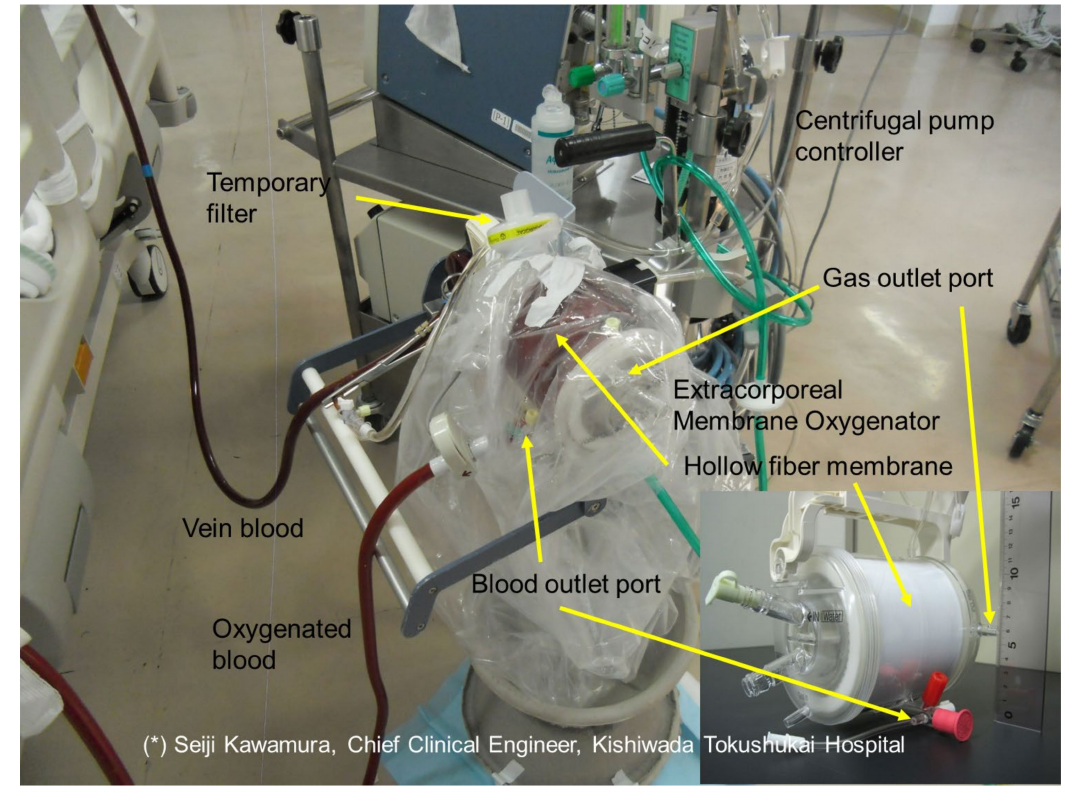
Figure 1. A measure to prevent the scattering of SARS-CoV-2 from extracorporeal membrane oxy- genator, wrapped with a vinyl chloride